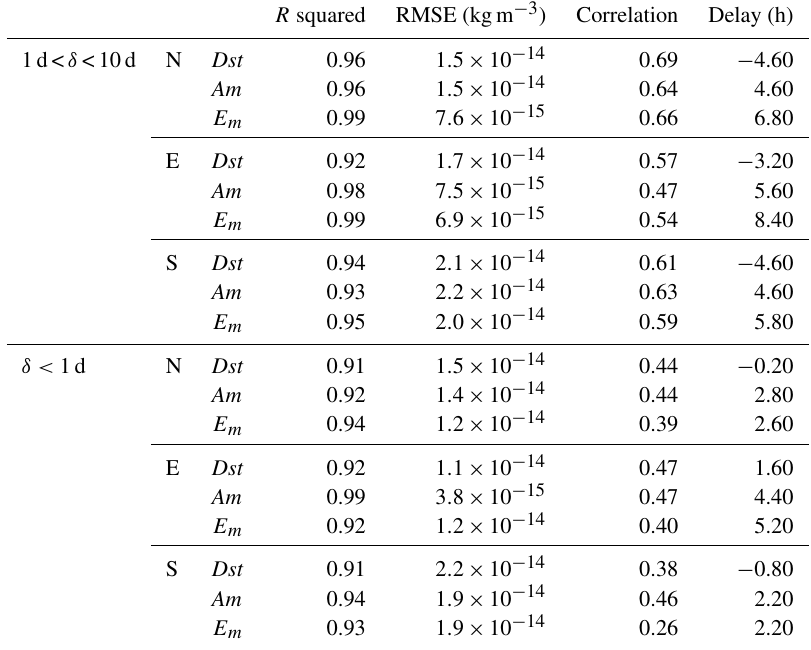
Table 3. Best delay, correlation, and goodness of fit corresponding to Fig.